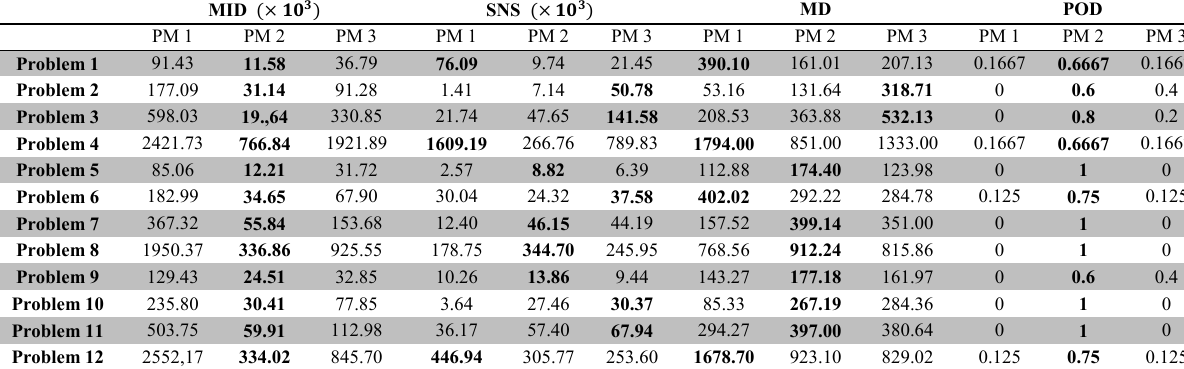
Performance metrics of the algorithms for the case study MID (cid:4666)(cid:3400) (cid:2778)(cid:2777) (cid:2780) (cid:4667) SNS (cid:4666)(cid:3400) (cid:2778)(cid:2777) (cid:2780) (cid:4667)